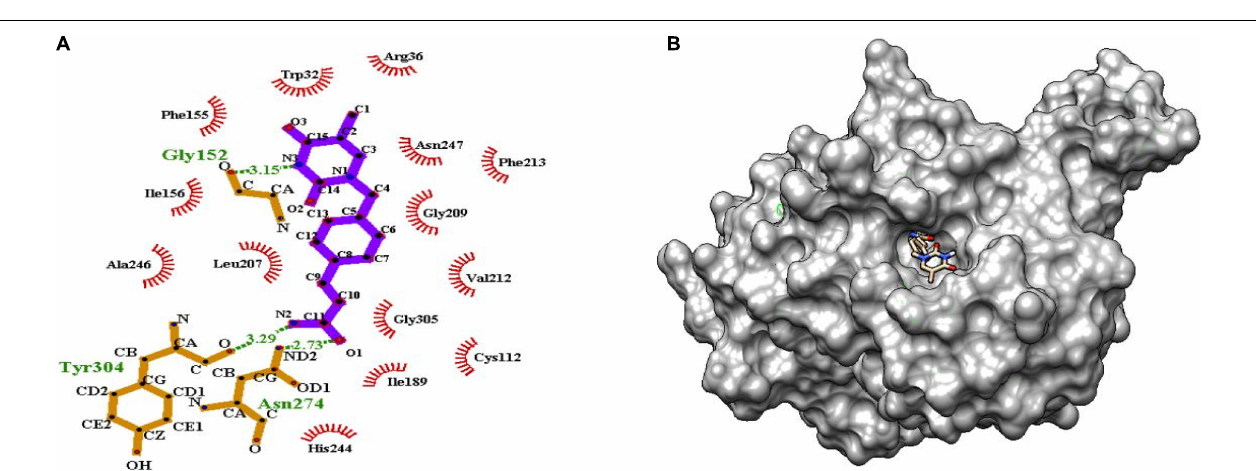
in H-bond interaction with residues Asn247, Arg249, Asn274,